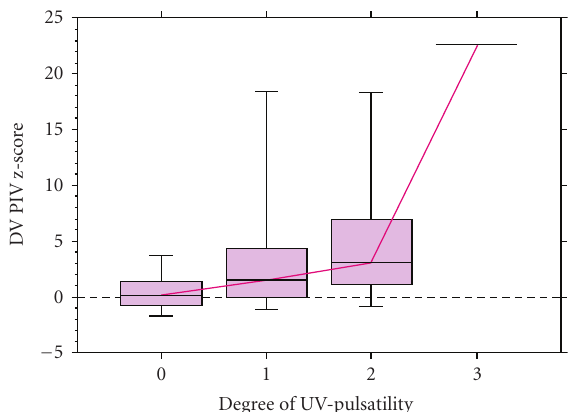
Figure 3: Umbilical venous pulsations in relationship with ductus venosus z-score of pulsatility index for veins. 0 = normal blood velocity; 1 = flow with a single pulsation; 2 = double pulsation; 3 = triple pulsating flow